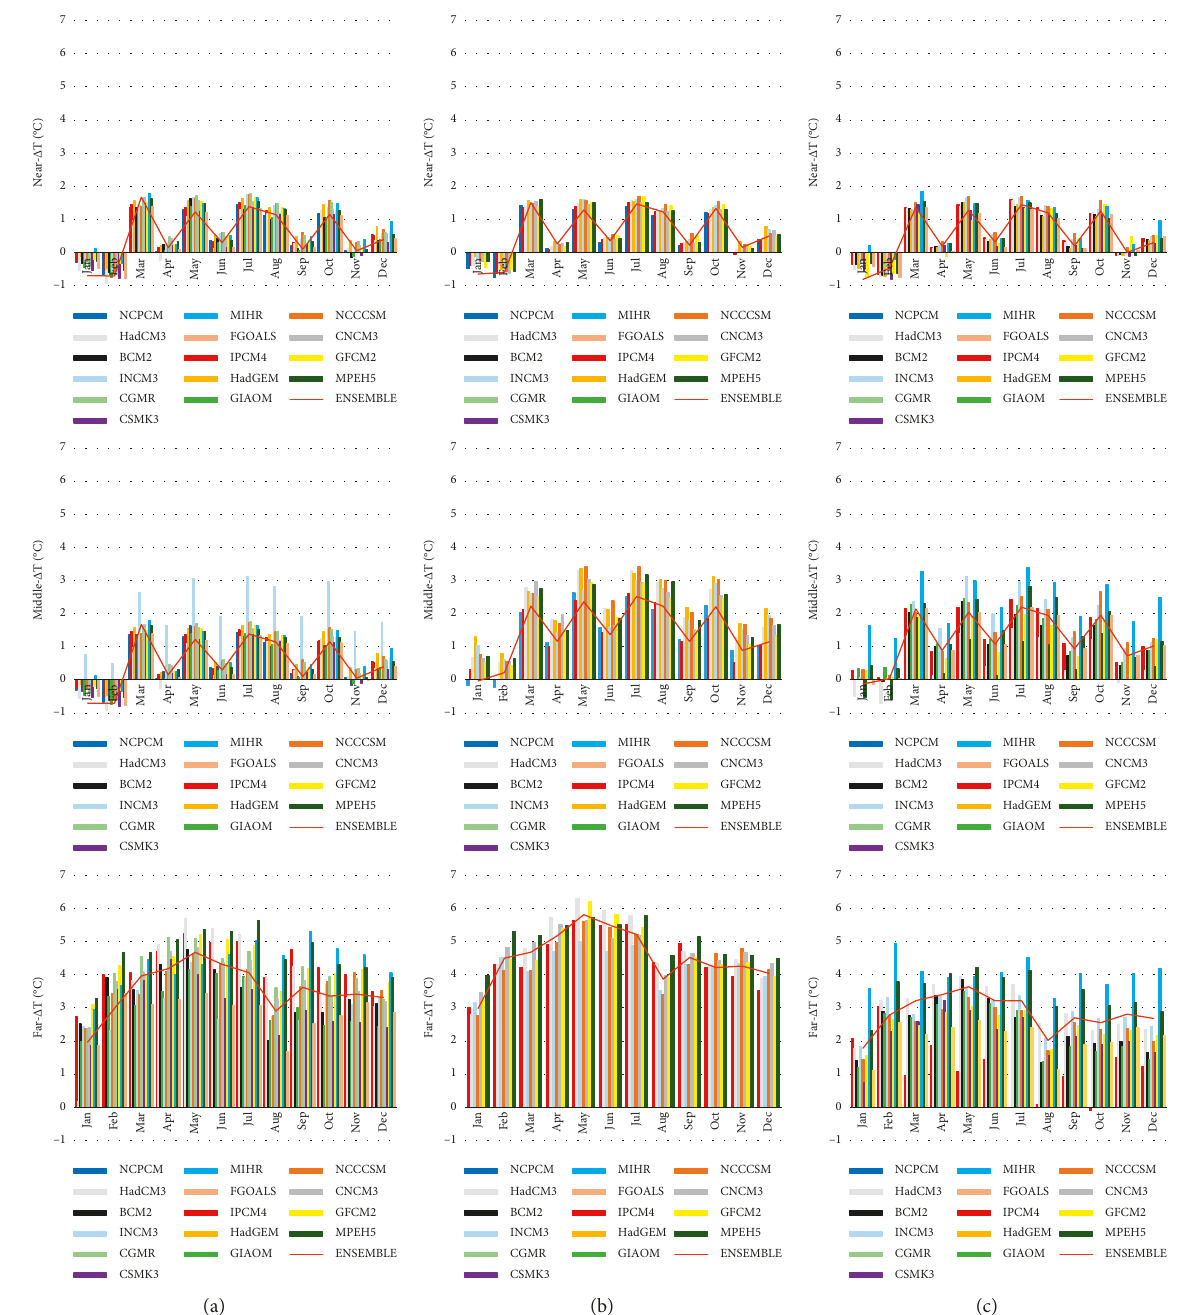
Figure 3: Tmax changes under different GCMs and ensemble approach versus the observational values for the three future periods under scenarios (a) A1B, (b) A2, and (c)